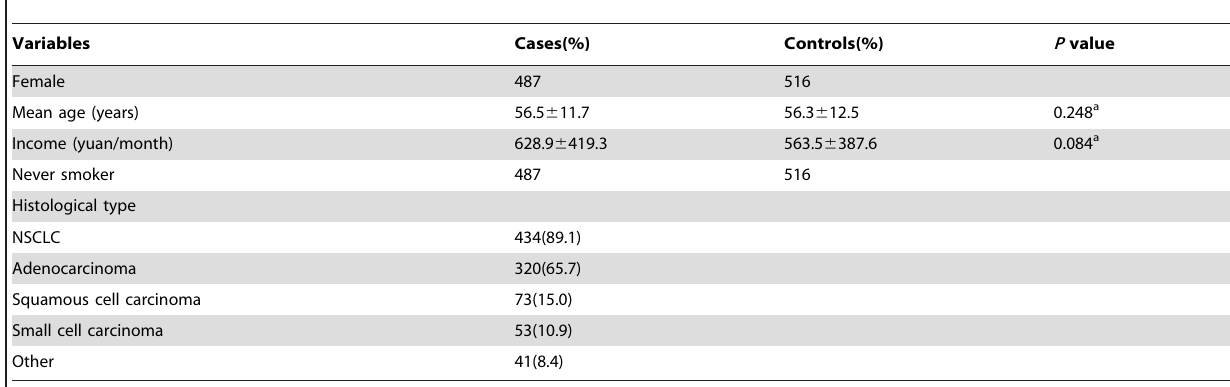
Table 1. Characteristics of lung cancer cases and